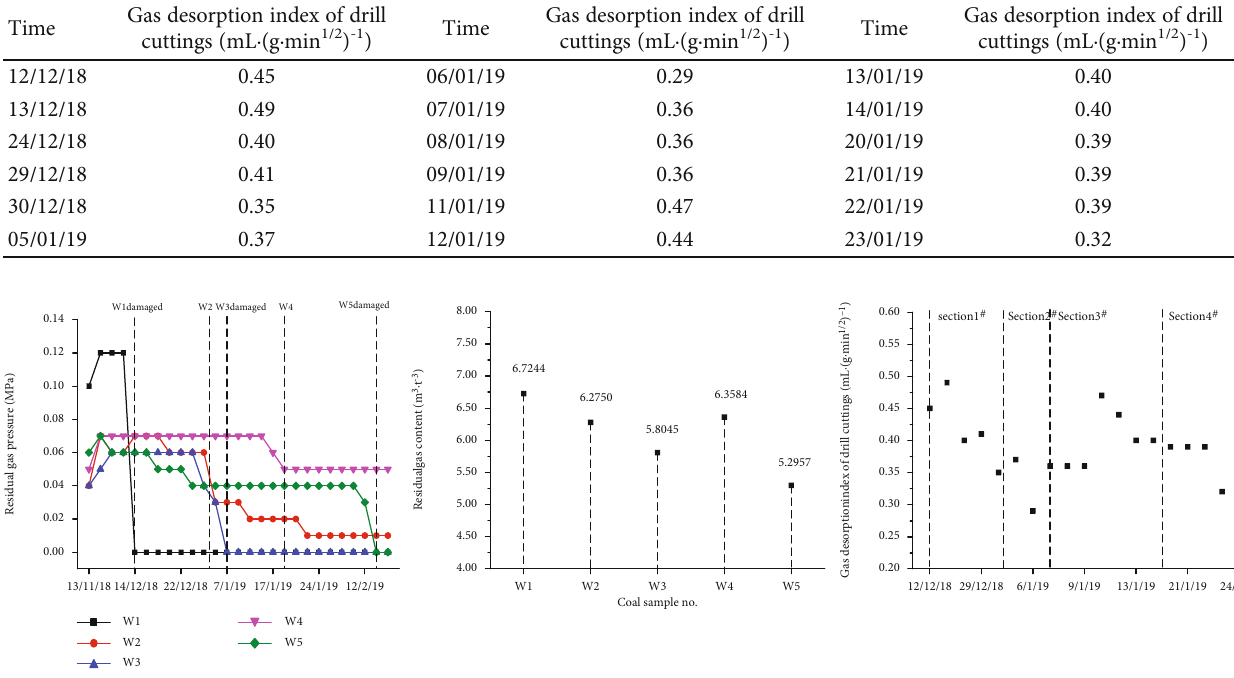
Figure 17: Monitoring results: coal seam gas parameters. Table 12: Stress and gas